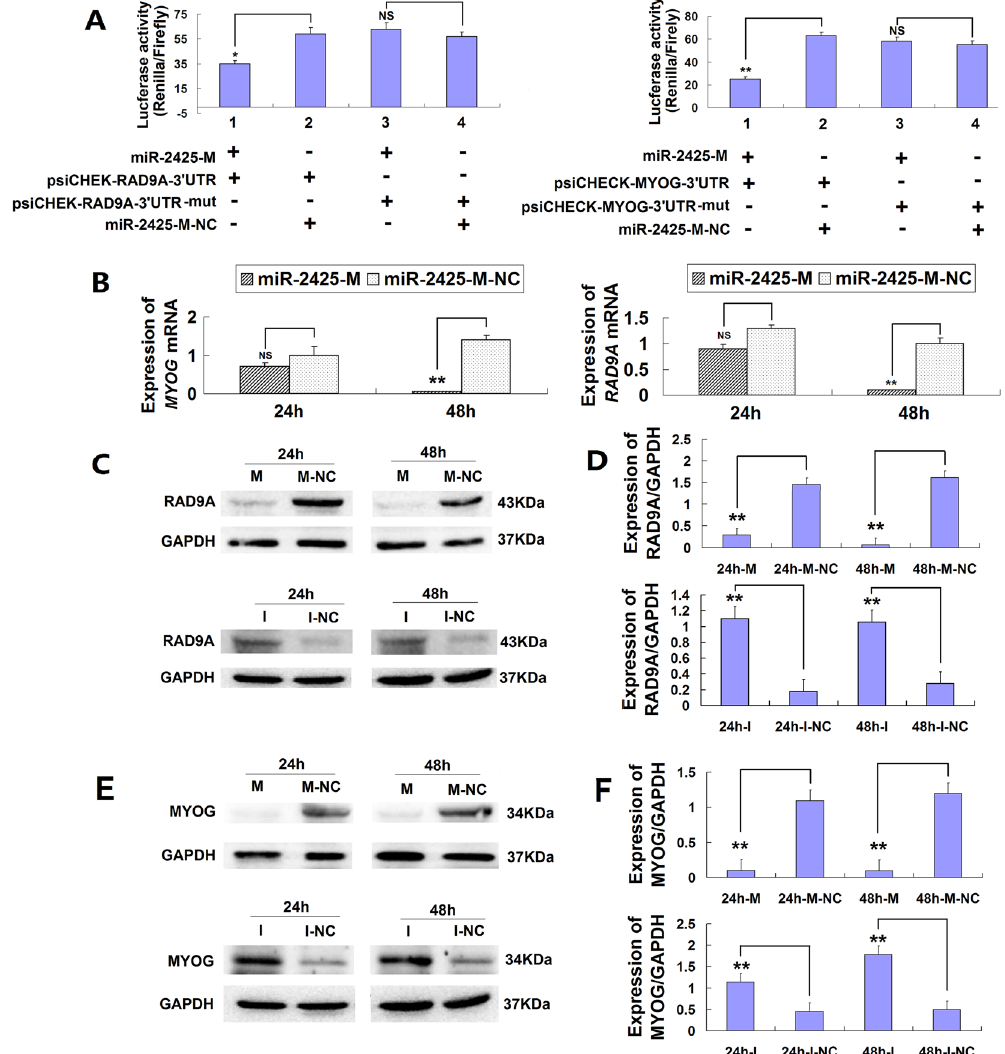
Figure 4. MiR-2425-5p regulates RAD9A and MYOG expression. ( A ) MiR-2425-5p binding to the 3 ′ -UTR of RAD9A and MYOG was examined with luciferase reporter assays performed by psiCHECK-2 vector. ( B ) RAD9A and MYOG mRNA expression after miR-2425-M transfection at 24 h, 48 h, and 72 h. ( C ) RAD9A protein expression after transfection of miR-2425-M or miR-2425-I. ( D ) Quantified data from ( C ). ( E ) MYOG protein expression after transfection of miR-2425-M or miR-2425-I. ( F ) Quantified data from ( E ). * P < 0.05, ** P < 0.01, NS: no significant